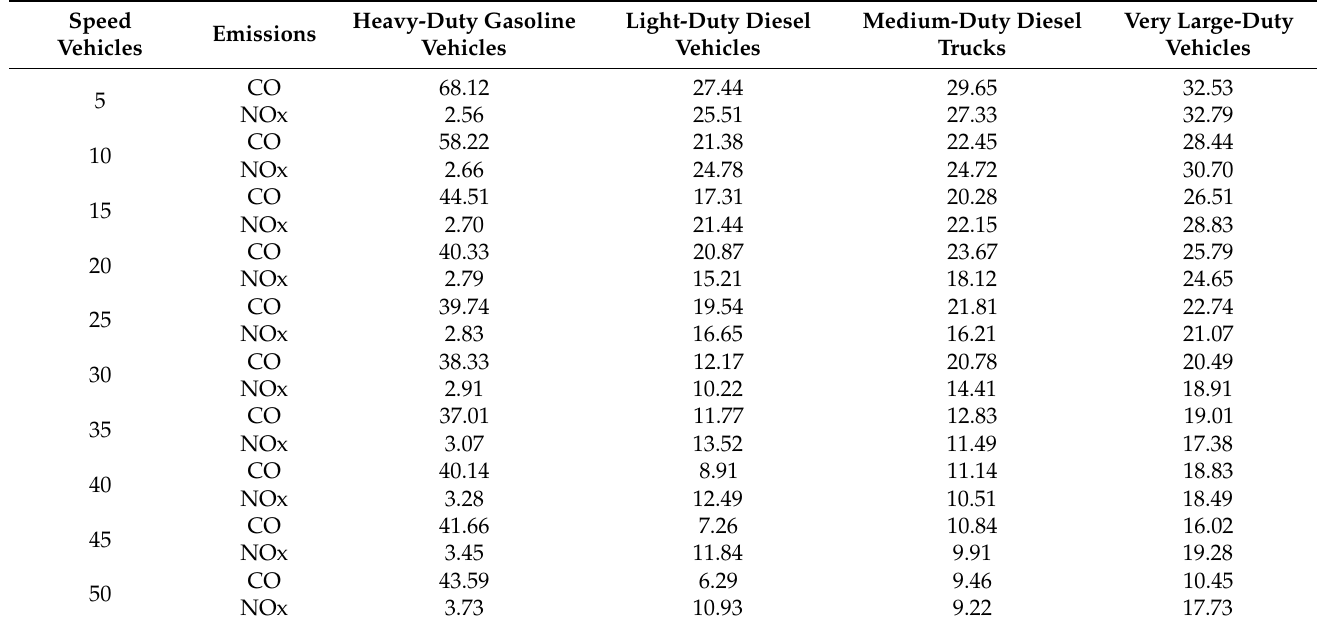
Table 1. Exposure of noxious emission factors according to speed